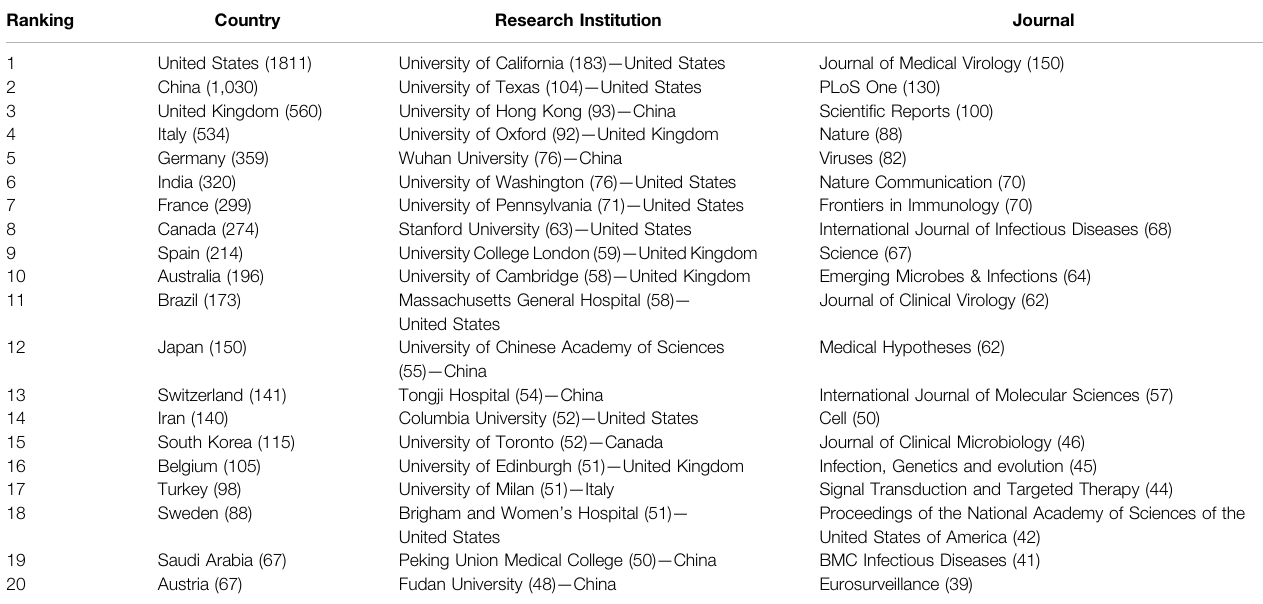
TABLE 1 | Top 20 proli fi c countries, research institutions and journals in this emerging fi eld. Ranking